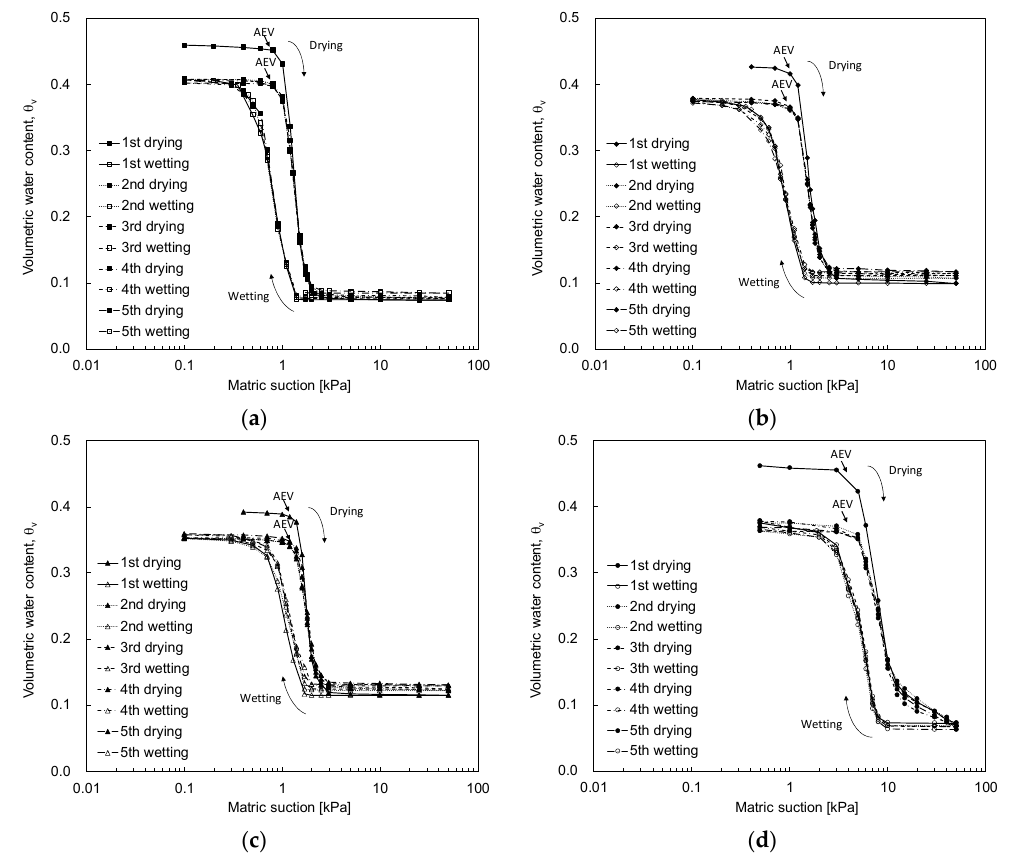
Figure 10. Multiple-cycles of the soil-water characteristic curve: ( a ) void ratio of e = 0.85 for J30-50 sand; ( b ) void ratio of e = 0.80 for J30-50 sand; ( c ) void ratio of e = 0.75 for J30-50 sand; ( d ) void ratio of e = 0.85 for F100 sand. AEV denotes the air entry value.